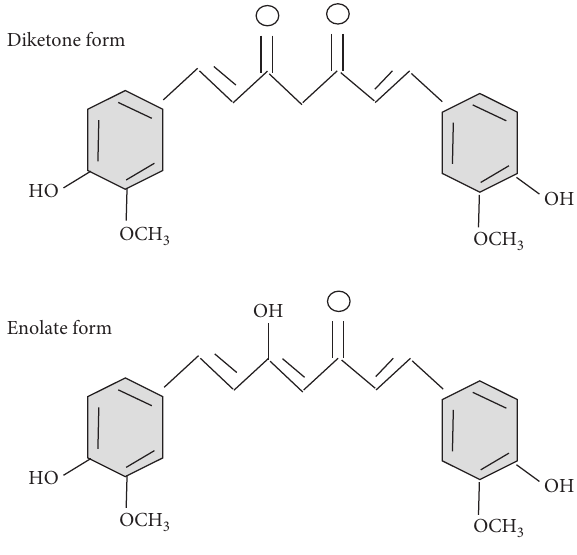
Figure 1: Structure of